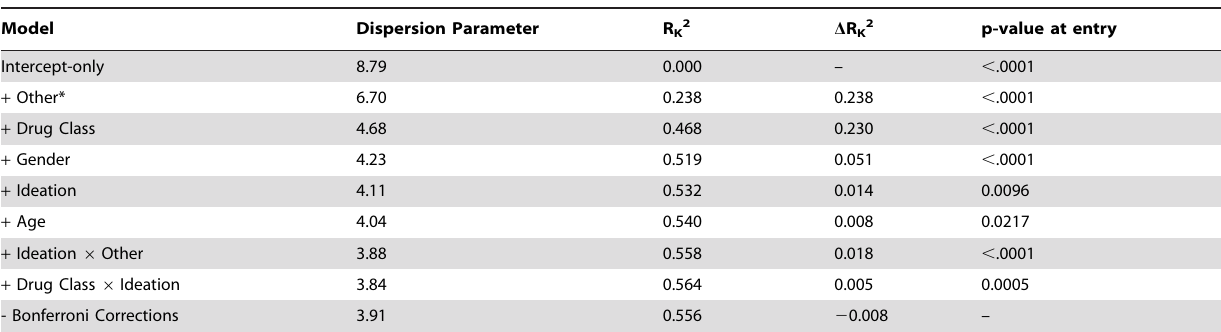
Table 4. Model fit